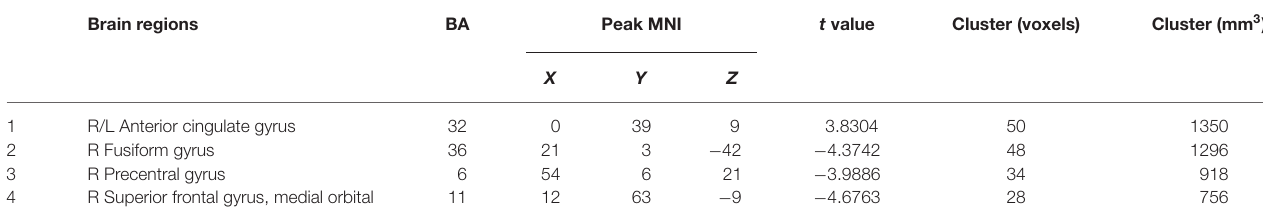
TABLE 3 | Brain regions with different regional homogeneity (ReHo) values between T2DM patients and healthy control groups. Brain regions